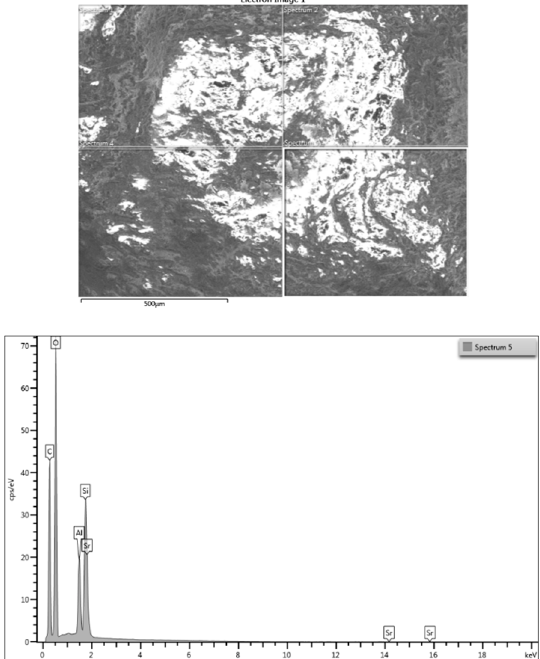
Figure 3. Energy dispersive X-ray (EDX) analysis for 3D-printed E-Dent 100.